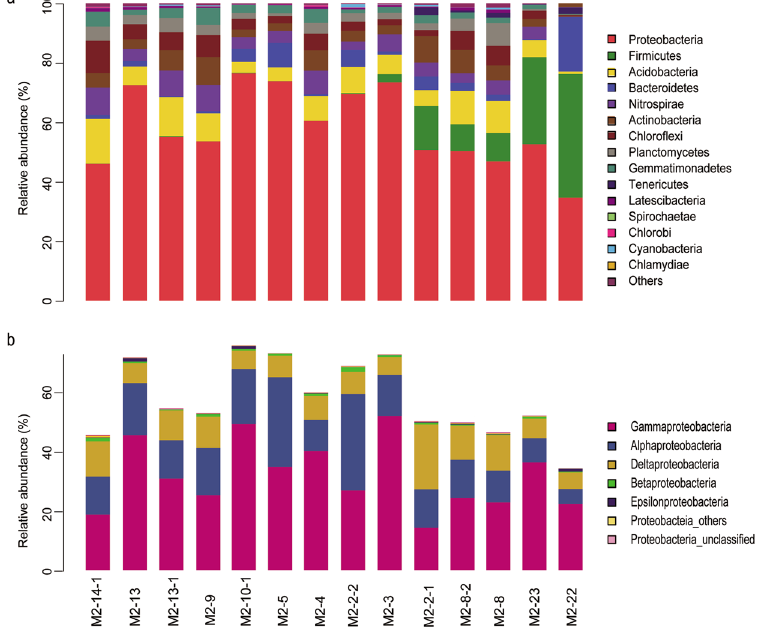
Figure 3. Bacterial 16 rRNA gene community composition at 14 stations at the Kexue seamount. Panel ( a ) Taxonomic assignments were obtained from Illumina MiSeq sequencing datasets, using the RDP classifier tool and the Silva database, respectively. Only phyla with a relative abundance ≥ 1% are shown. Phyla with a relative abundance < 1% were grouped as ‘Other’. Panel ( b ) Taxonomic assignments at the class level within the phylum Proteobacteria.